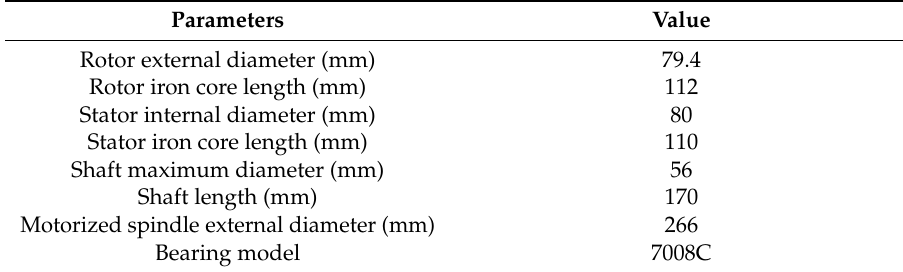
Figure 4. Finite element model of the 170MD30 motorized spindle. ( a ) Geometrical model, ( b ) finite element analysis meshing model. Table 1. The main parameters of the motorized spindle.